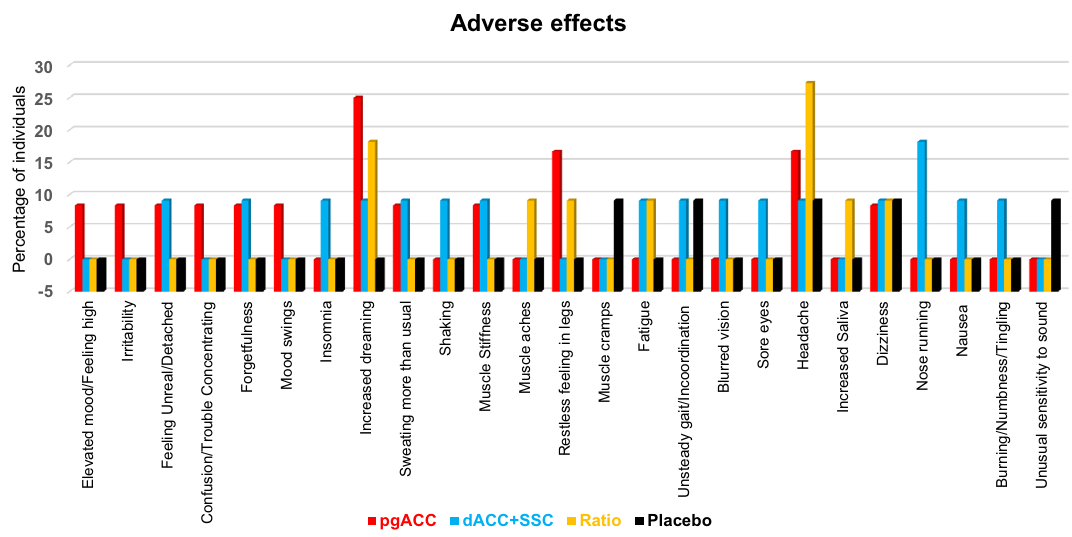
Figure 4. Adverse effects reported by participants during the neurofeedback treatment sessions. pgACC: pregenual anterior cingulate cortex, dACC: dorsal anterior cingulate cortex, SSC: primary somatosensory